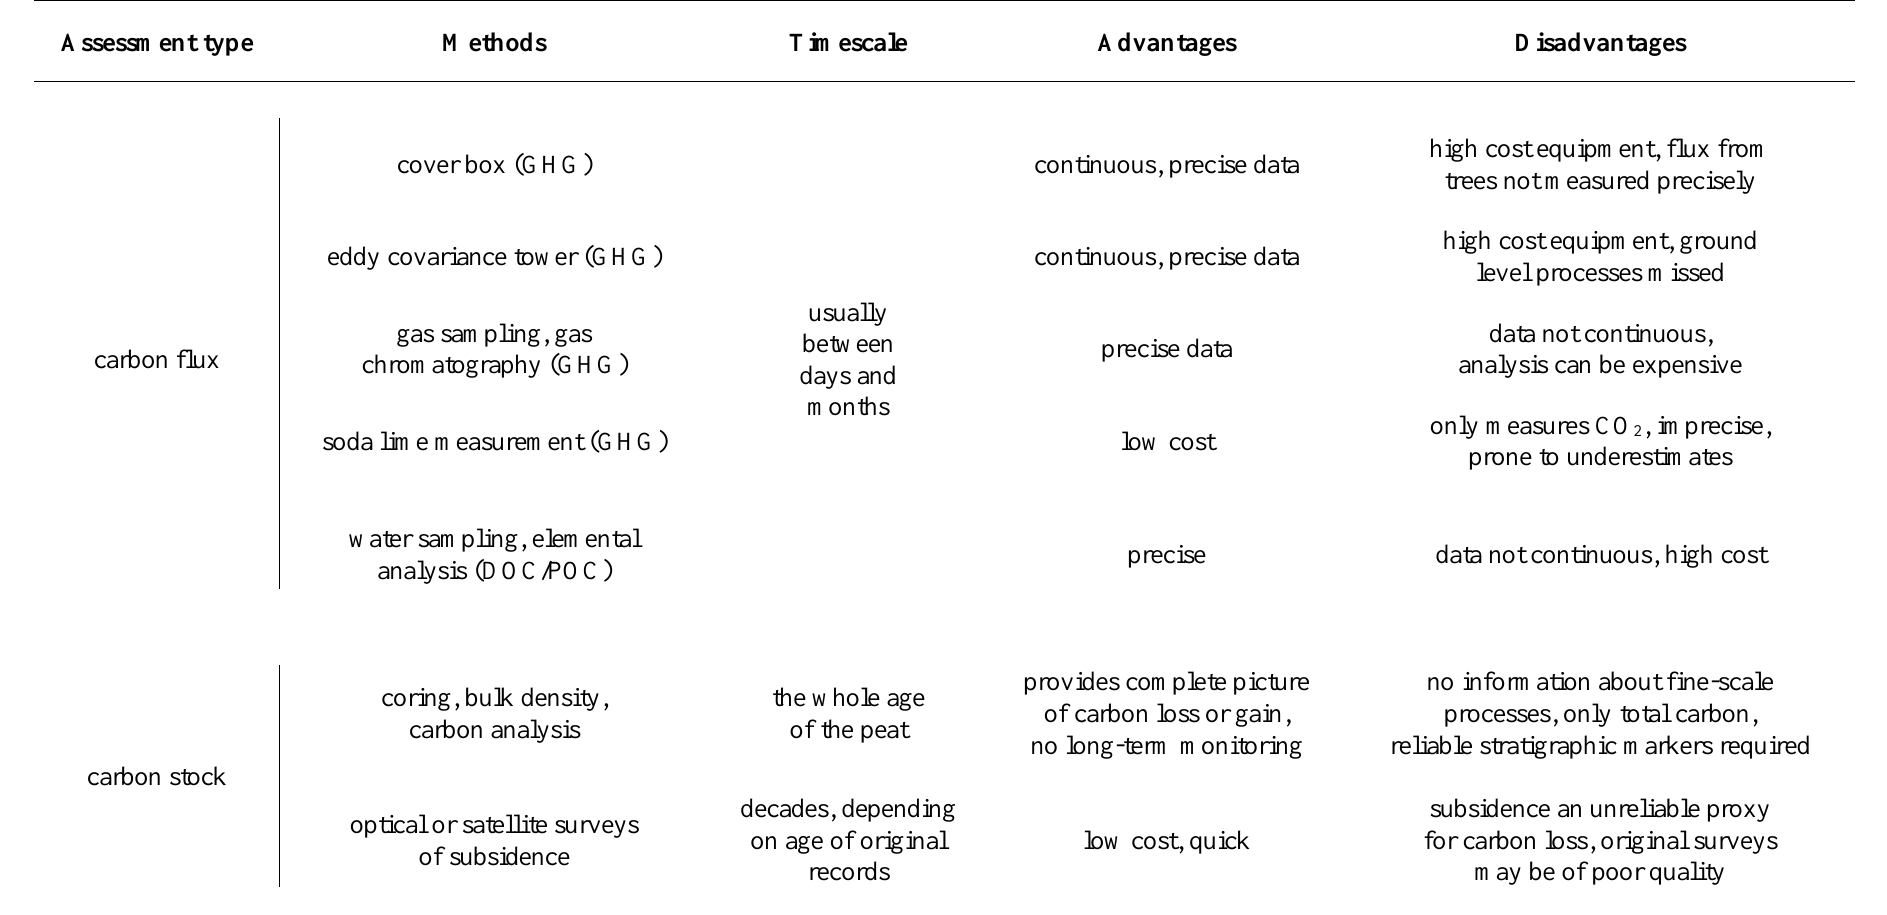
Table 1. Methods used for determining carbon budgets in